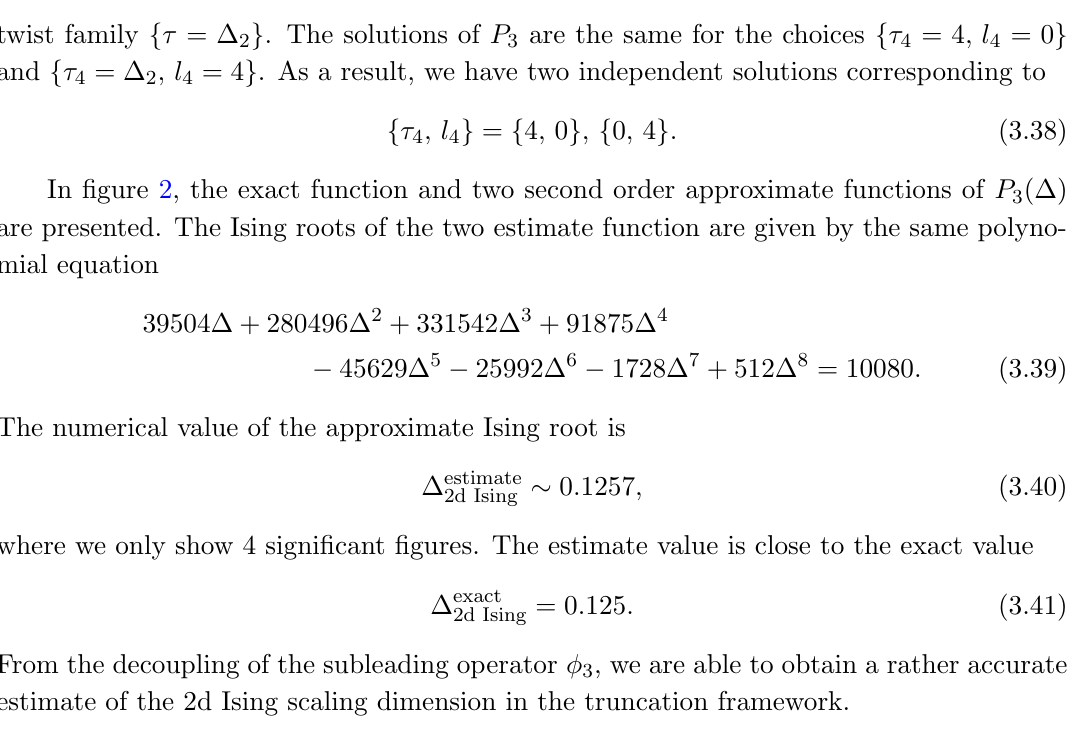
Figure 2 . The exact values (blue) of the OPE coe(cid:14)cient P 3 ((cid:1)) as a function of the scaling dimension (cid:1) and its second order estimates with di(cid:11)erent (cid:30) 4 operators: f (cid:28) 4 ; l 4 g = f 4 ; 0 g (orange), f (cid:28) 4 ; l 4 g = f 0 ; 4 g (green). The two approximate functions almost coincide when (cid:1) is smaller than the Ising root. The estimate functions are close to the exact function between (cid:1) = (cid:0) 0 : 05 and (cid:1) = 0 : 15. The Ising roots are rather accurate in the second order approximations, but the Lee- Yang roots are less accurate than the (cid:12)rst order